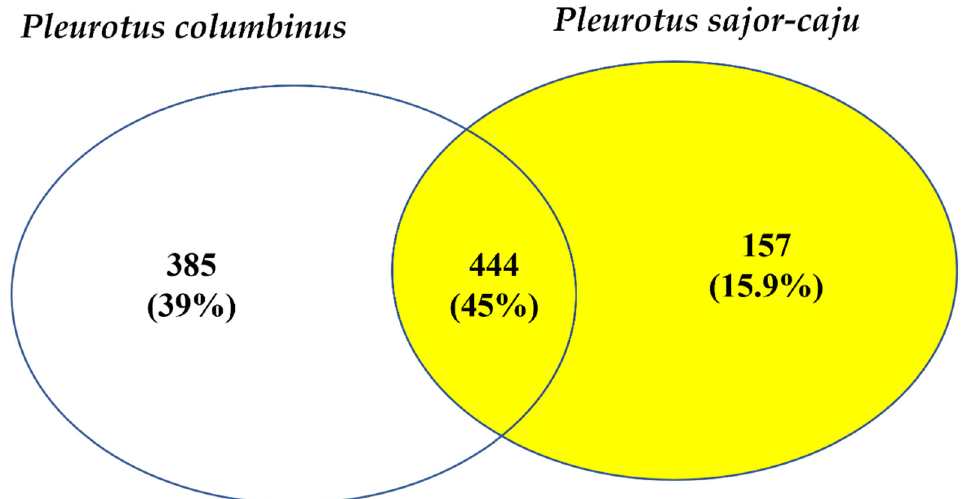
Figure 2. Venn diagram showing the common identified proteins between the three mushroom species Pleurotus columbinus , Pleurotus sajor-caju , and Agaricus bisporus .